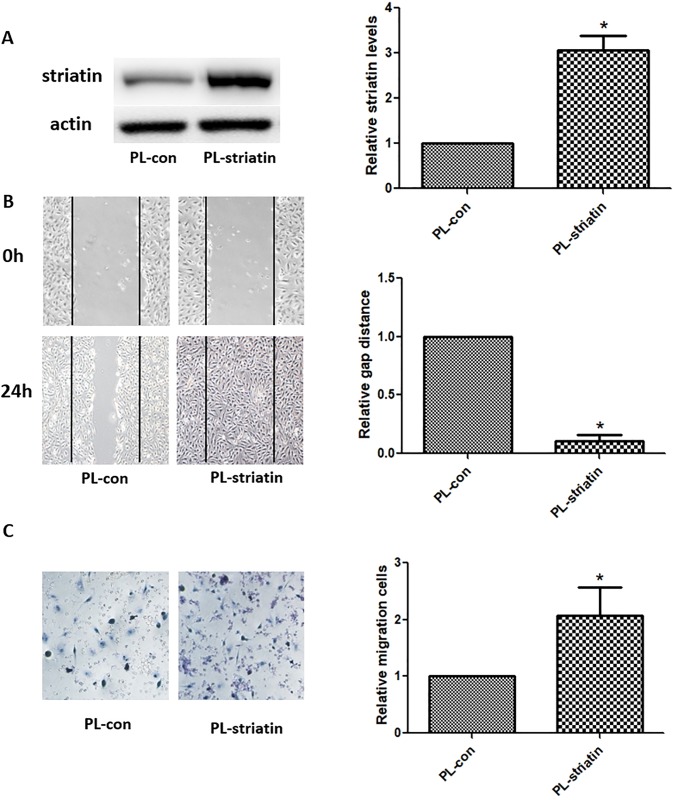
Striatin overexpression in HUVECs promotes cell migration.(A) HUVECs were transfected with control plasmids (PL-con) or striatin targeted plasmids (PL-striatin). Striatin densitometry values were adjusted to actin intensity, then normalized to expression from the control sample. Expression in PL-con group was normalized to 1, *p<0.01 versus CON. Bars represent SD, n = 4. (B) After transfection assays, HUVECs were scrapped to create a cell-free (wounded) area. Migration was monitored. Representative images of cell migration are shown. Gap distance in PL-con group was normalized to 1, *p<0.01 versus CON. Bars represent SD, n = 6. (C) After transfected with striatin plasmids, transwell experiments were performed. Representative images of transwell experiments are shown. The number of the invaded cell in the lower surface of the membrane in PL-con group was normalized to 1, *p<0.01 versus CON. Bars represent SD, n = 6.